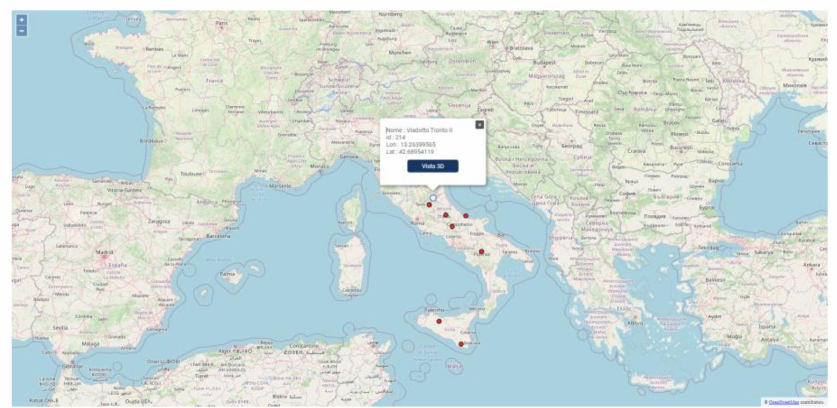
Figure 12. Two-dimensional map.